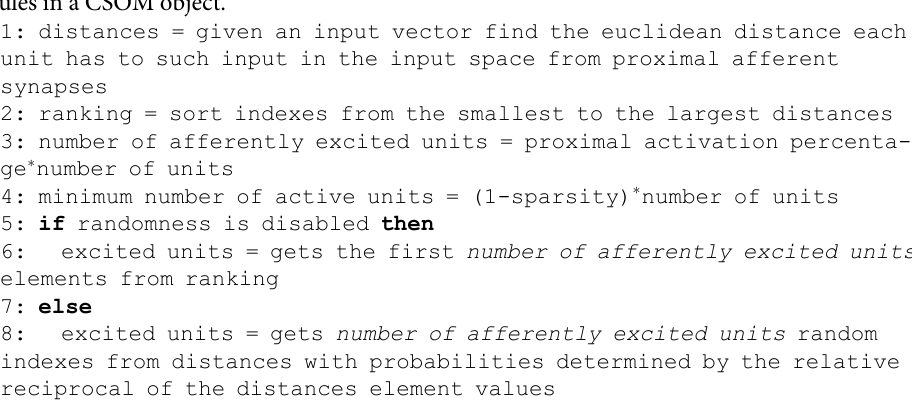
Fig 7. Dynamic cellular activation in a CC in the EL. A red cortical column is linked with two green cortical columns by means of distal dendrites. (A) Cellular activation in green CCs–highlighted yellow cells–puts neural units in red CC in a partially depolarized– predictive state highlighted in blue. (B) Cluster of neural cells activated by afferent inputs. Left: A substantial amount of partially depolarized cells are in the afferently excited cellular clusters. Right: There is no substantial amount of partially depolarized cells inside afferently excited cellular clusters. (C) CC with active cellular units highlighted in yellow. Left: Sparse pattern of cellular activation. Right: Massive pattern of activation. Algorithm 3 Units activation (Part 1) . This algorithm establishes the activation rules in a CSOM object.